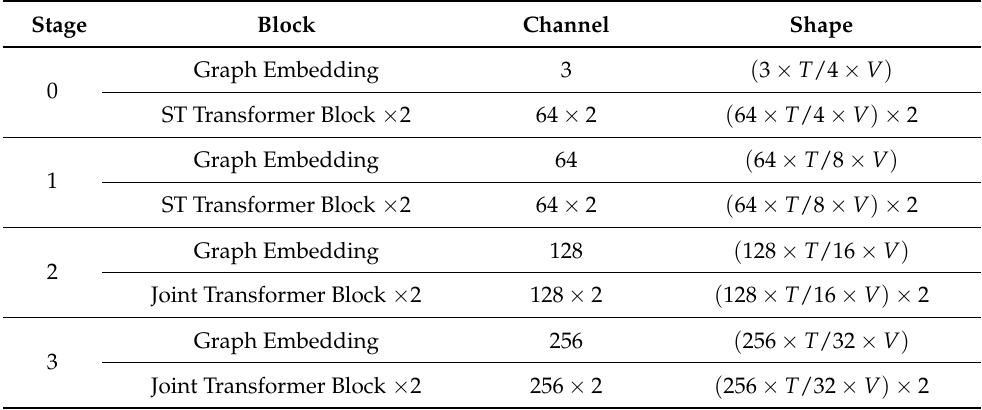
Figure 2. Implementation of the pyramid spatial-temporal graph transformer (PGT). A pyramid architecture is designed for multi-scale feature learning. The model consists of four stages with similar modules to capture the long-range correlations in the spatial and temporal dimensions. Each stage has a graph embedding module and a spatial-temporal transformer block. The temporal dimension decreases exponentially with each stage, while the spatial dimension stays the same. In this way, the spatial granularity is retained, and temporal redundancy is removed. Table 1. The architecture parameters of the pyramid spatial-temporal graph transformer on the NTU-RGBD 60